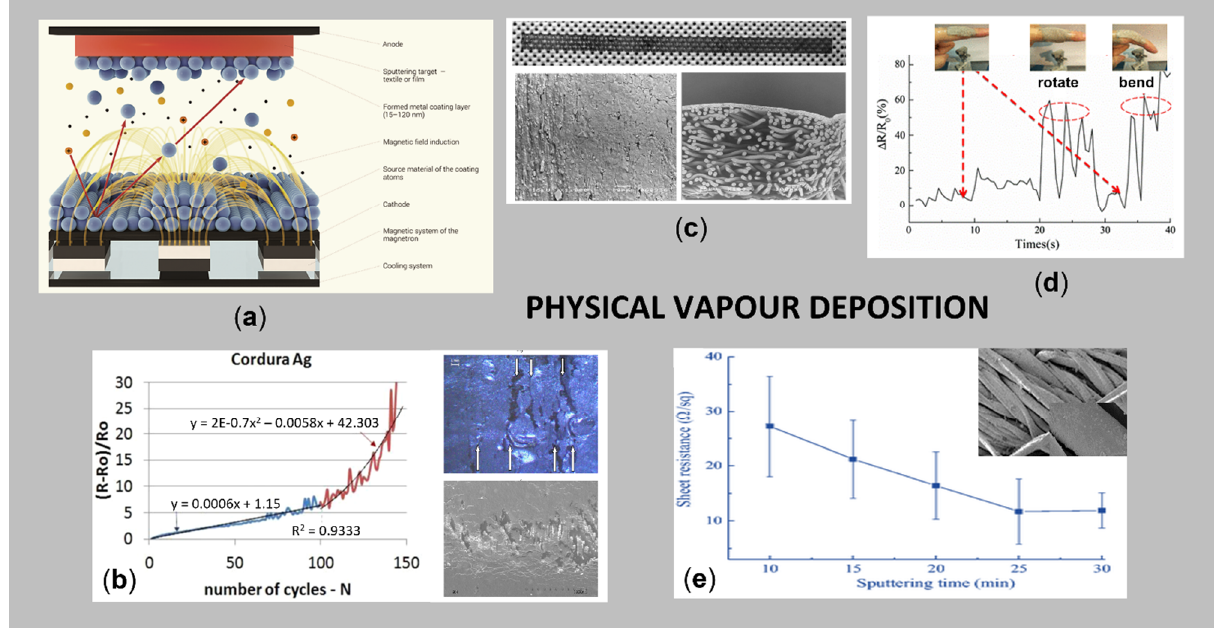
Figure 6. ( a ) Basic mechanism of the magnetron sputtering process; ( b ) relative change of resistance of Ag coated Cordura subjected to cyclic bending, and corresponding microscopic and SEM images after 10,000 bending cycles (reprinted with permission from Ref. [107] Copyright 2021, Springer); ( c ) magnetron sputtered Cu transmission lines on polypropylene nonwoven and responsible SEM images: longitudinal view and cross-section (reprinted with permission from Ref. [110] Copyright 2021, Łukasiewicz Research Network—Institute of Biopolymers and Chemical Fibres); ( d ) monitoring the finger motions by Ag/G-coated cotton: rotation and bending (adapted from Ref. [111]); ( e ) sheet resistance of Ag/polypyrrole-coated cotton as a function of sputtering time and corresponding SEM at 10 min (adapted from Ref. [115]).